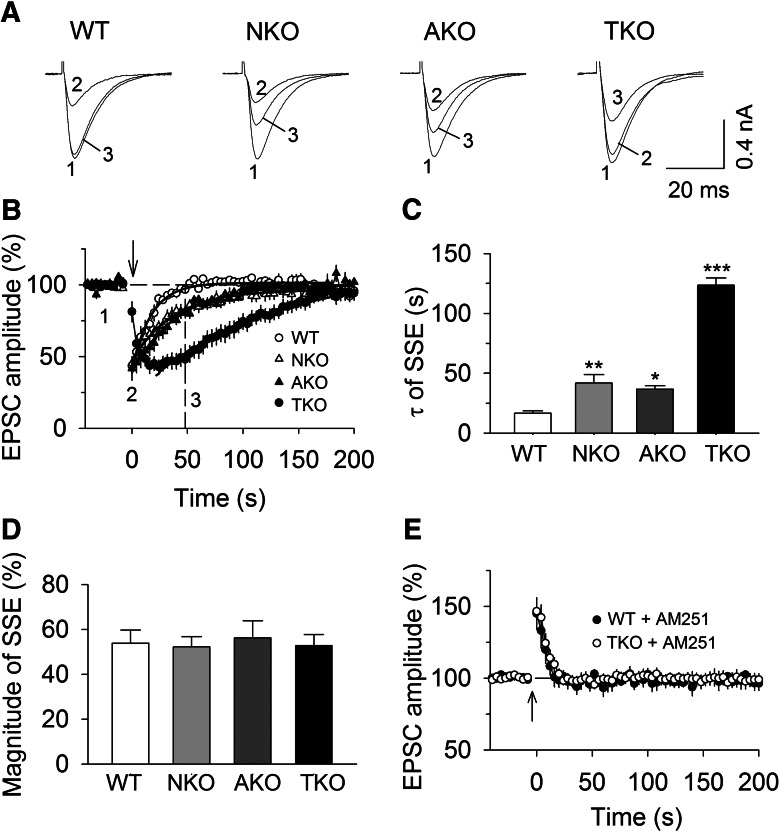
Effects of global and cell-type-specific knock-out of MAGL on SSE. A, B, Sample traces (A) and average time courses of PF-EPSCs (B) in response to tetanic stimulation (50 Hz, 1 s; indicated by arrow) in cerebellar slices prepared from MAGL-TKO, -NKO, and -AKO mice and their wild-type (WT) littermates (n = 9–10 cells). The solid lines are single exponential fitting curves of the decay of PF-SSE, which yielded the decay time constant (τ) of SSE shown in C. C, τ of SSE was significantly increased in MAGL-TKO, -NKO, and AKO mice compared with that of WT control (*p < 0.05, **p < 0.01, ***p < 0.001). D, MAGL-TKO, -NKO, and -AKO did not significantly alter the magnitude of SSE (p > 0.05). E, The CB1R antagonist AM 251 (2 µm) blocked SSE in WT and MAGL-TKO slices, resulting in indistinguishable PTP of EPSCs (n = 8–10; p > 0.05).